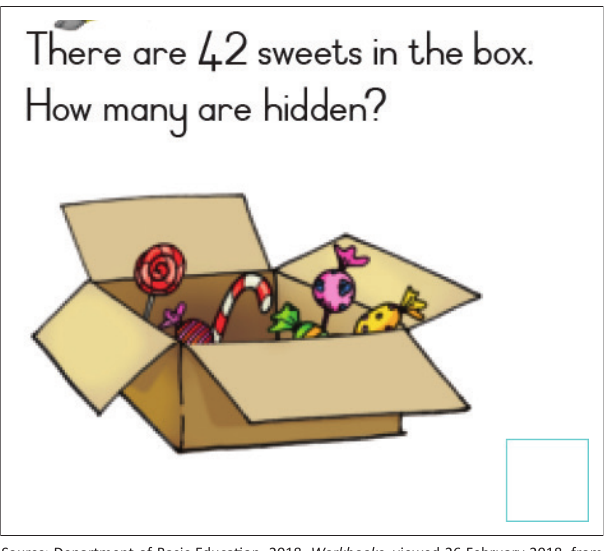
FIGURE 12: Word problem using a picture to provide some information. FIGURE 13: Frequency of different types of word problems, by grade.